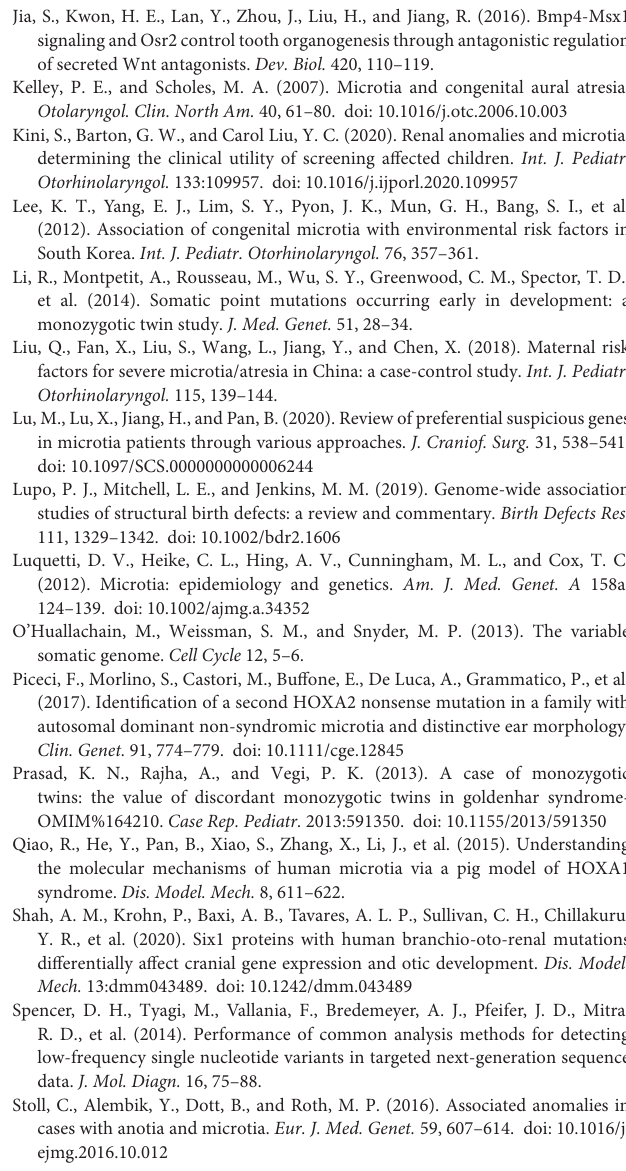
Supplementary Figure 1 | The wild-type and mutated-type secondary structures of MUC6 mutations. (A) The mutation ( MUC6 c.5705C > T:p.T1902I) was predicted to modify the local secondary structure of the protein, which were circled as red and blue; (B) The mutation ( MUC6 c.4553C > T:p.T1518I ) was predicted to modify the local secondary structure of the protein circled as red and blue. WT means wild-type; MT means mutated-type. Supplementary Figure 2 | The wild-type and mutated-type crystal structures of MUC6 mutations. (A1) Global view of the crystal structures of wild-type proteins of MUC6; (A2) Global view of the mutated-type ( MUC6 c.5705C > T:p.T1902I) proteins. The change of protein structure brought by the amino acid substitution was circled. Local homology prediction demonstrated high confidence rate (86.13%). (B2) Global view of the mutated-type ( MUC6 c.4553C > T:p.T1518I) proteins. The crystal structure was obviously different between the wild-type and mutated-type. Local homology prediction demonstrated high confidence rate (79.32%). WT means wild-type; MT means